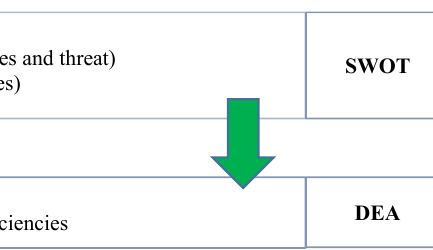
Fig 1: Methodology of the study